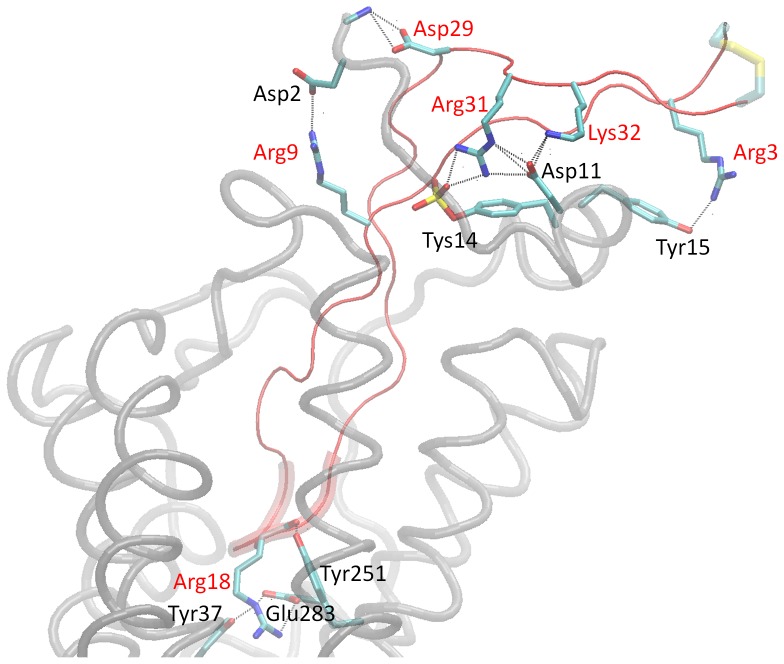
Important Intermolecular Polar Interactions;Molecular graphics image of important polar interactions corresponding to the complex with the lowest average binding free energy. The figure shows the salt bridges and specific important hydrogen bonds. The V3 loop is shown in tube and in red color, and the residue moiety 16–20 is shown in fat tube representation. The CCR5 is shown in light gray transparent tube representation. The salt bridge and hydrogen bonds are denoted in dashed lines and the participating V3 loop and CCR5 residue moieties are shown in licorice; V3 loop and CCR5 residues are annotated in red and black, color respectively. Hydrogen atoms are omitted for clarity, and the V3 loop disulfide bridge is shown in fat transparent licorice representation.